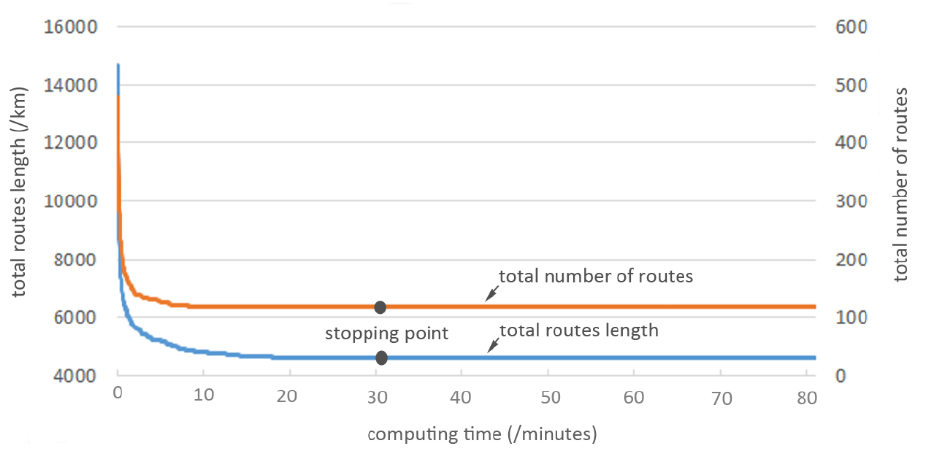
Figure 8 . The convergence of the total number of routes and the total routes length (Sh2a).